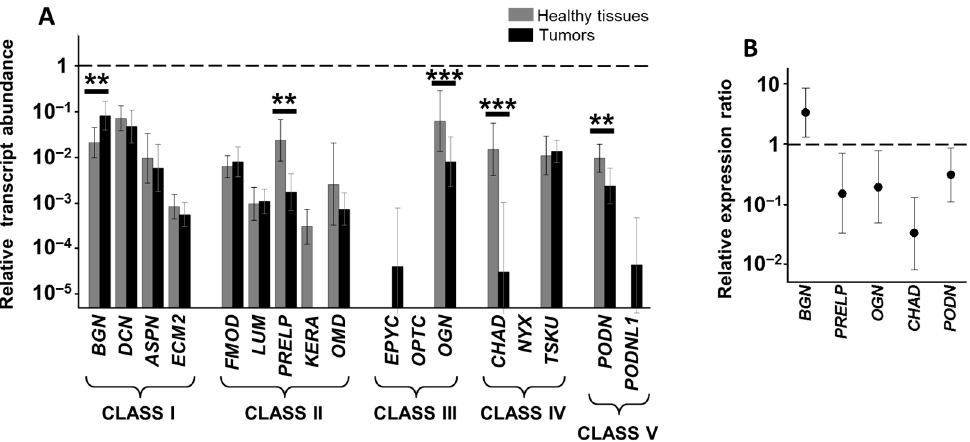
Figure 3. Differential transcription of SLRP genes in LSCC. ( A ) Relative transcript abundance of mRNAs for SLRPs, grouped by class. Relative abundance for healthy tissues (gray bars) and tumors (black bars) are plotted on a log scale for each gene assayed and spreads represent standard deviation. Statistically significant differences are denoted by **, and ***, which indicate p < 0.01, and p < 0.001, respectively. ( B ) Relative expression ratio of genes that show statistically significant differences; the values represent the relationship between the transcription levels observed in each tumor tissue versus healthy tissue from the same patient. Values on the Y axis are represented on a logarithmic scale.